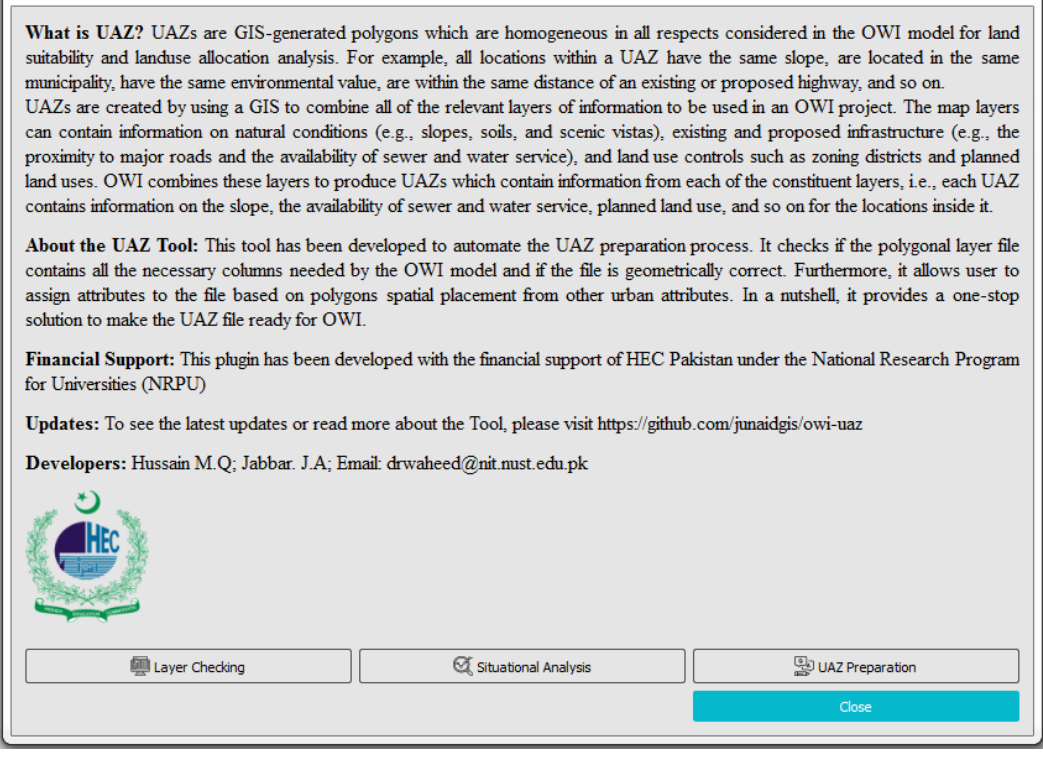
Figure 6. Uniform Analysis Zones (UAZ) Preparation Plugin; landing screen.